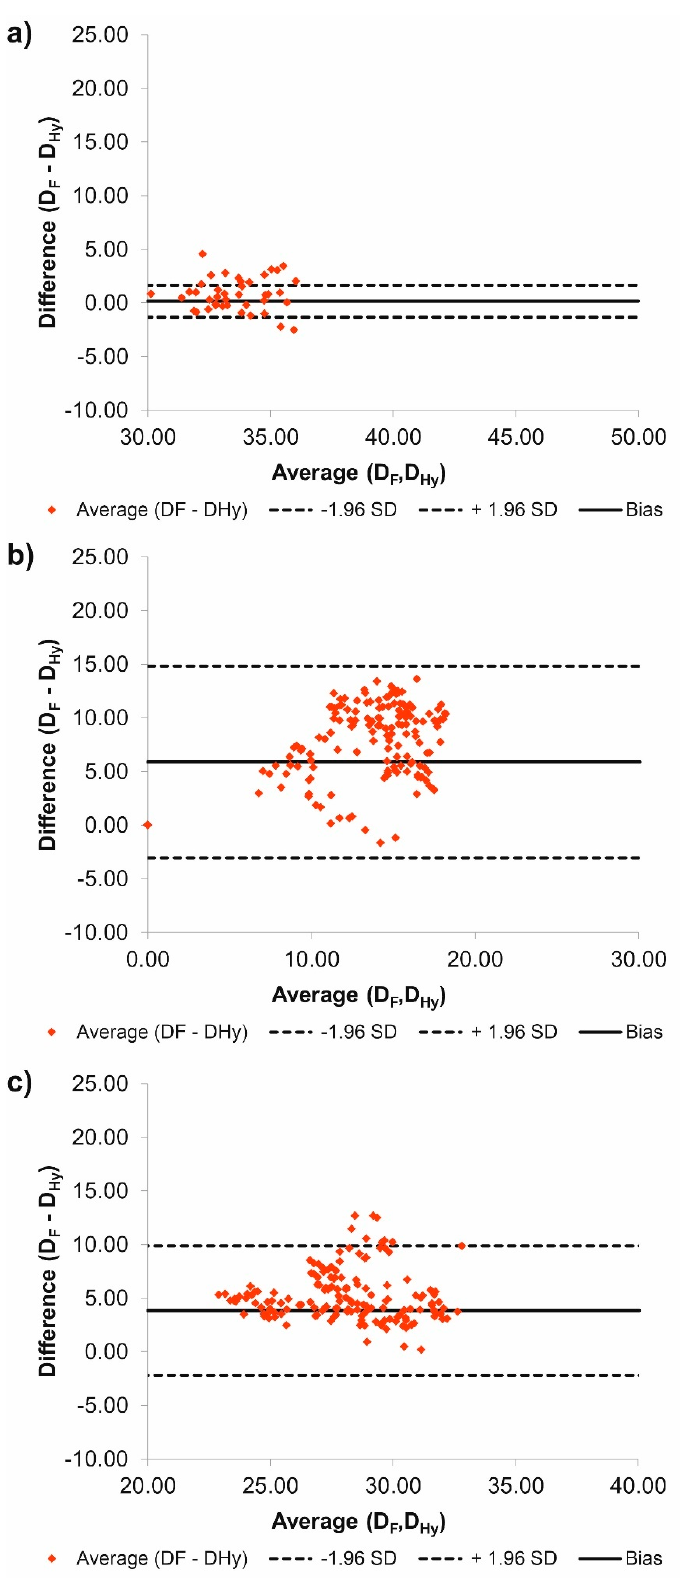
Figure 4. Comparison of D F and D Hy with the use of Bland–Altman analysis for: ( a ) Common duct, ( b ) true duct, and ( c ) false duct. For all analyzes p > 0.05.